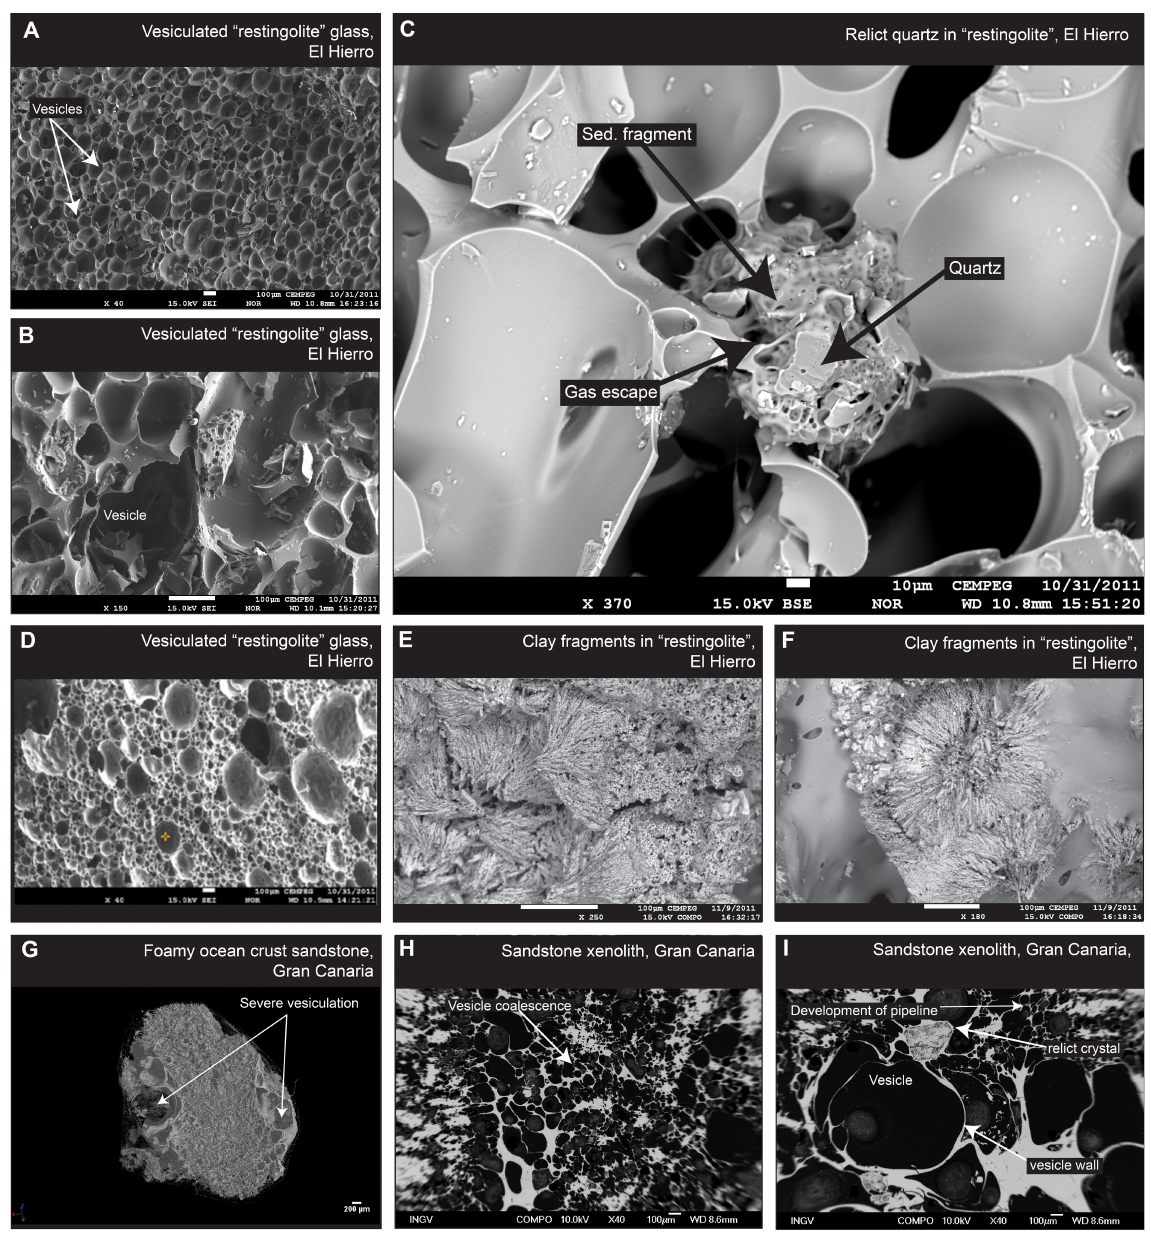
Fig. 4. SEM images of “restingolites” (A–F) and comparative images of Gran Canaria ocean crust sediment xenoliths (G–I) . (A) Pervasive micro-vesicularity in early El Hierro floating stones. (B) and (D) Details of vesicle distribution and vesicle wall textures. (C) High resolution image of sedimentary fragment in early El Hierro floating stone that has not yet fully melted. The melt surrounding the fragment has SiO 2 of 89% and a several-tens-of-microns large quartz crystal is seen in the centre of the image (compare Table 2). (E) and (F) Remnants of clay aggregates found in early El Hierro floating stones. Note in F these relicts are surrounded by glass. (G) Synchrotron X-ray computed micro-tomography image of a vesicular sedimentary xenolith from Gran Canaria, showing textures and compositions similar to the early El Hierro floating stones (compare Table 3). (H) and (I) SEM images of vesicular sedimentary xenoliths from Gran Canaria with relict quartz crystals and thin vesicle walls, i.e. they display textures very similar to the El Hierro “restingolite” suite.